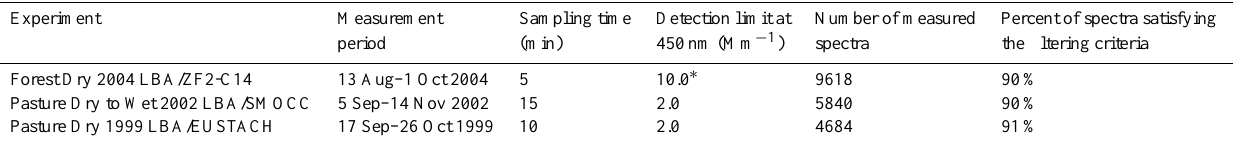
Table 1. For all the field experiments considered in this analysis, this table shows: measurement period; Aethalometer sampling time; calculated detection limit at 450nm; total number of measured attenuation spectra; percentage of spectra satisfying the filtering criteria described in the text. ( ∗ detection limit at 370nm).